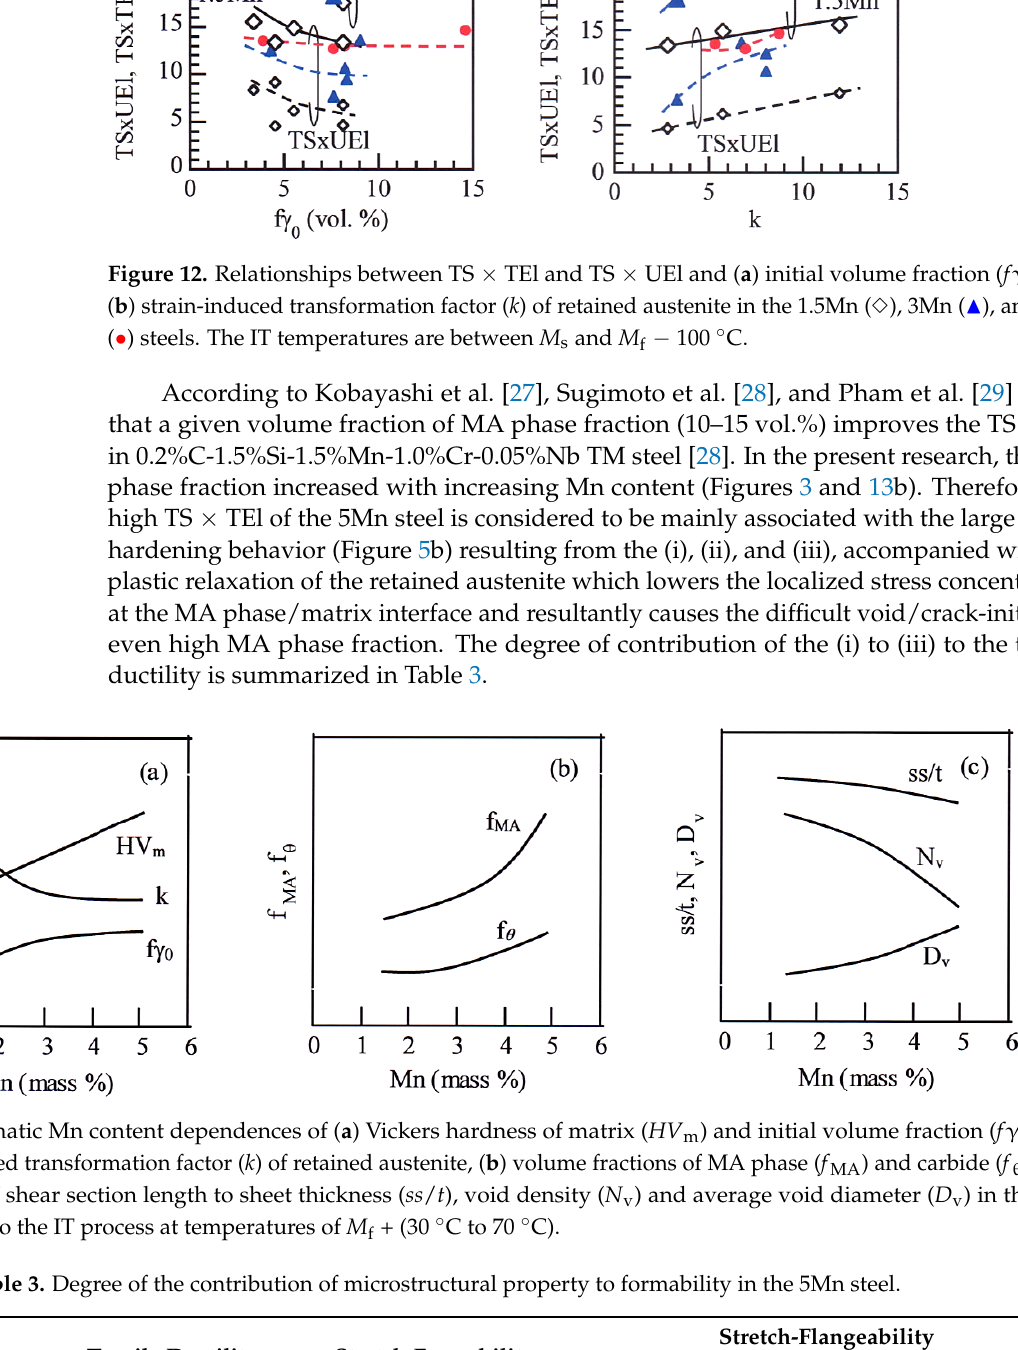
), 3Mn ( (cid:78) ), and 5Mn (cid:51)